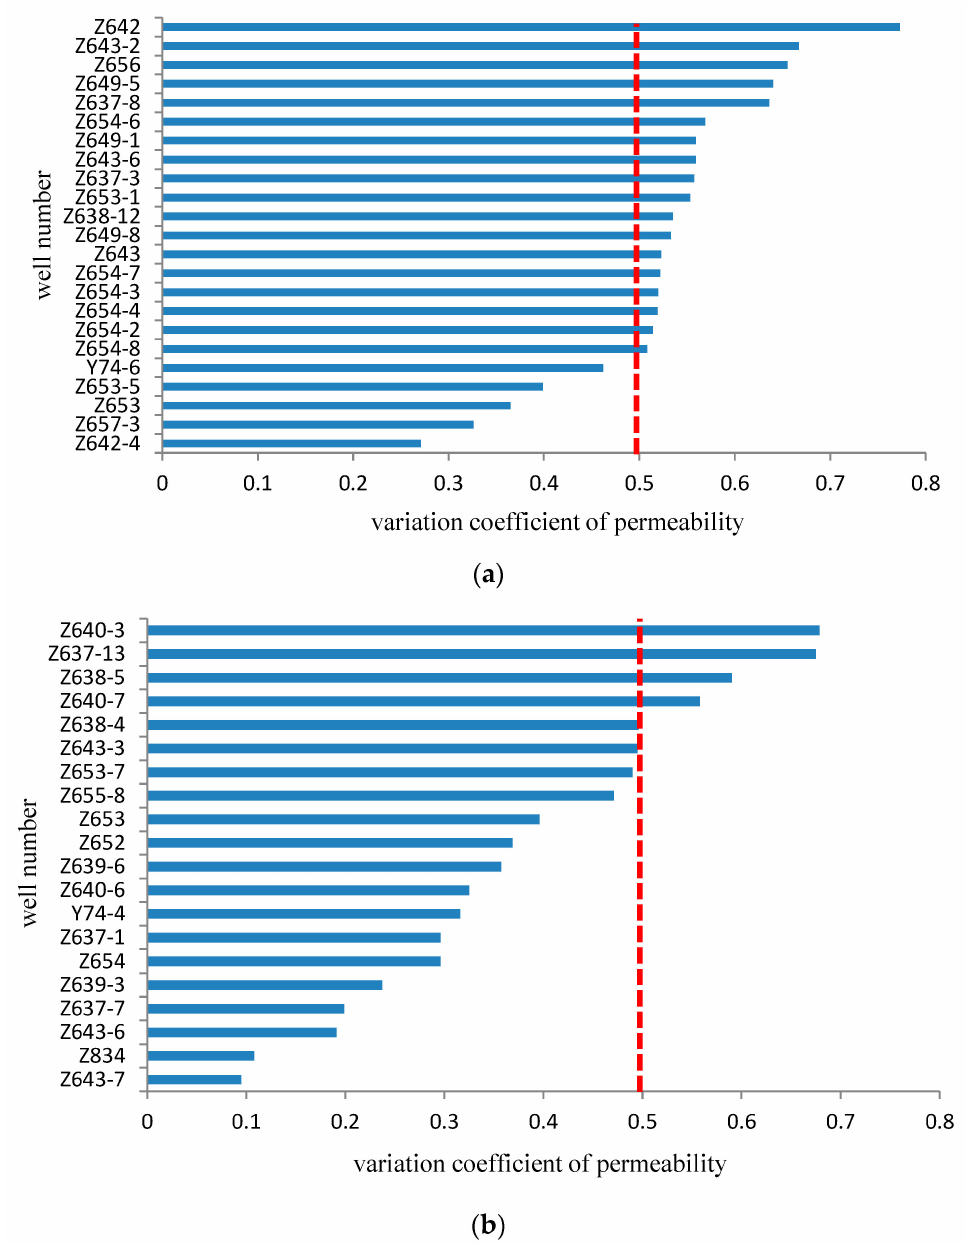
Figure 8. Distribution histogram of the variation coefficient of permeability in wells with water channeling ( a ) and without water channeling ( b ). Red dotted line means the value of variation coefficient of permeability is